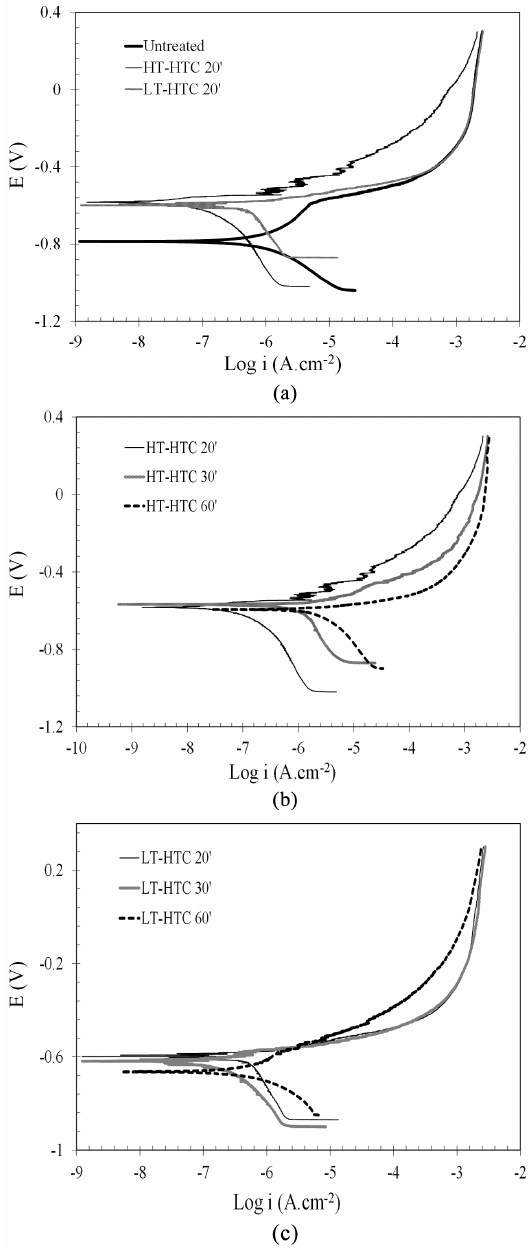
Figure 5. Polarization curves of uncoated and HTC coated AA 6061 specimens in 0.01 M NaCl. (a) Uncoated, HT-HTC and LT-HTC coated; (b) HT-HTC coated for different duration; (c) LT-HTC coated for different duration.